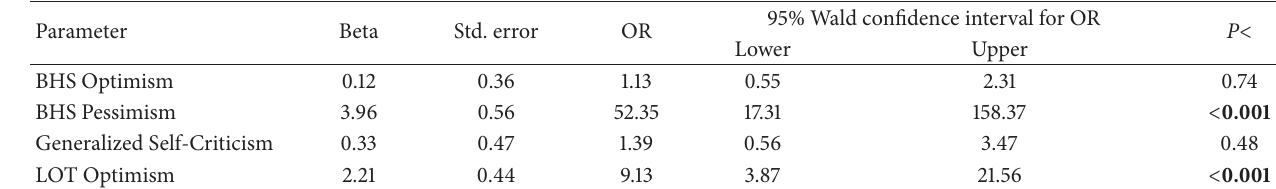
Table 3: Generalized linear model (criterion: